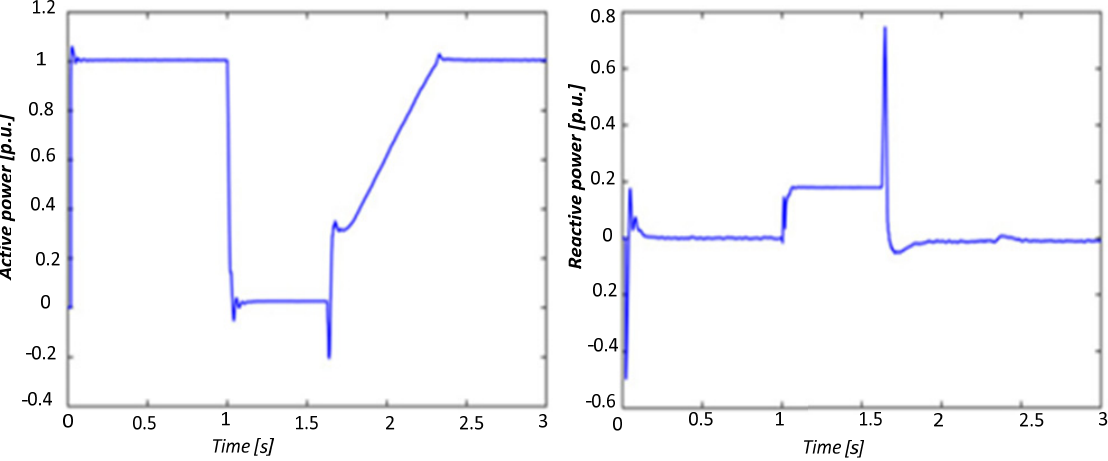
Figure 13. Active and reactive power responses in the case of a three-phase short-circuit.